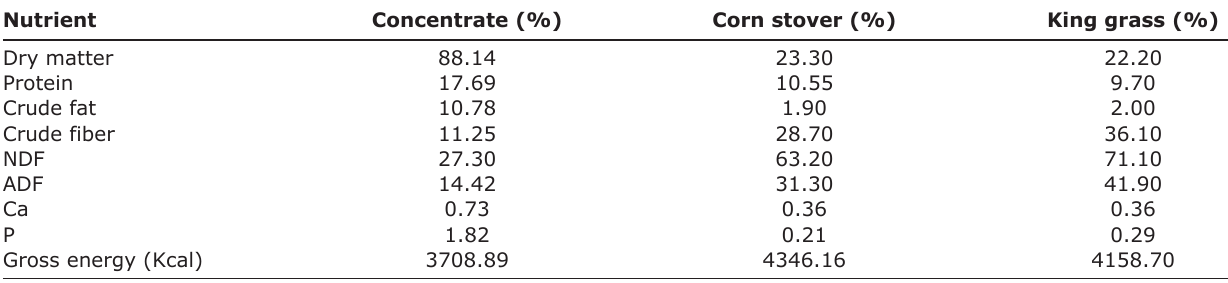
Table-1: Feeding concentration used in this study. Nutrient Concentrate (%) Corn stover